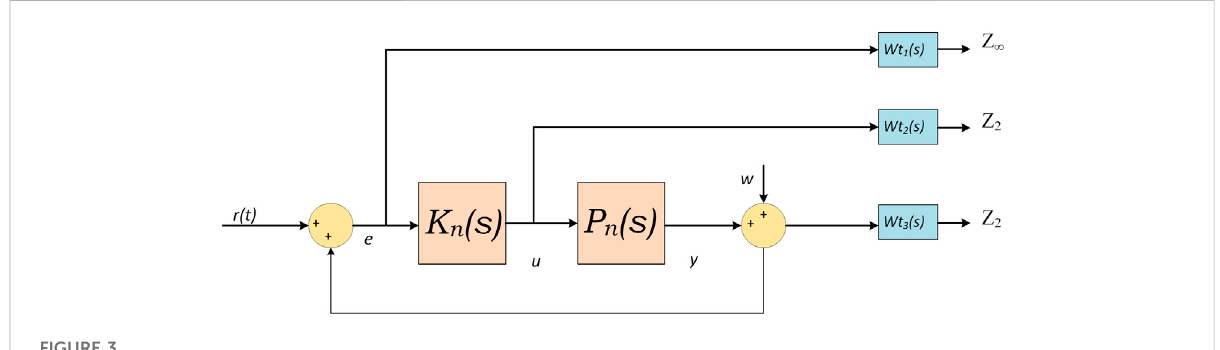
FIGURE 3 Robust mixed damping controller H 2 /H ∞ block